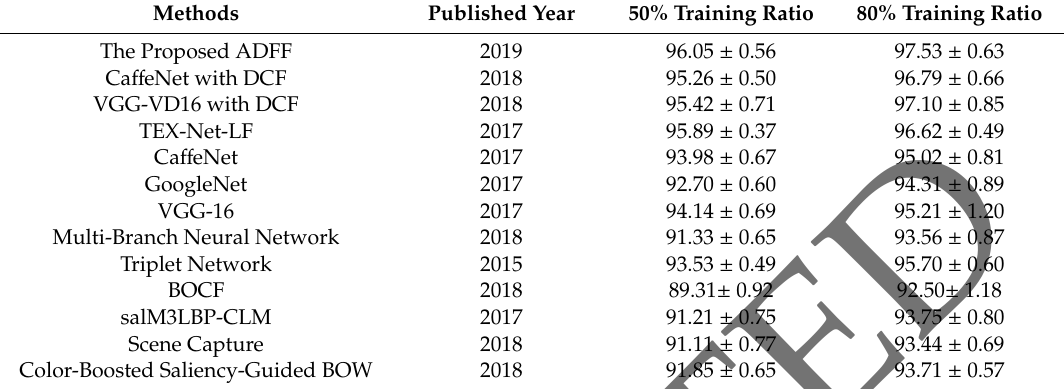
Table 2. Standard deviations and overall accuracy (%) of the attention-based deep feature fusion (ADFF) framework and all baseline algorithms with 80% and 50% training ratio in the UC-Merced dataset.